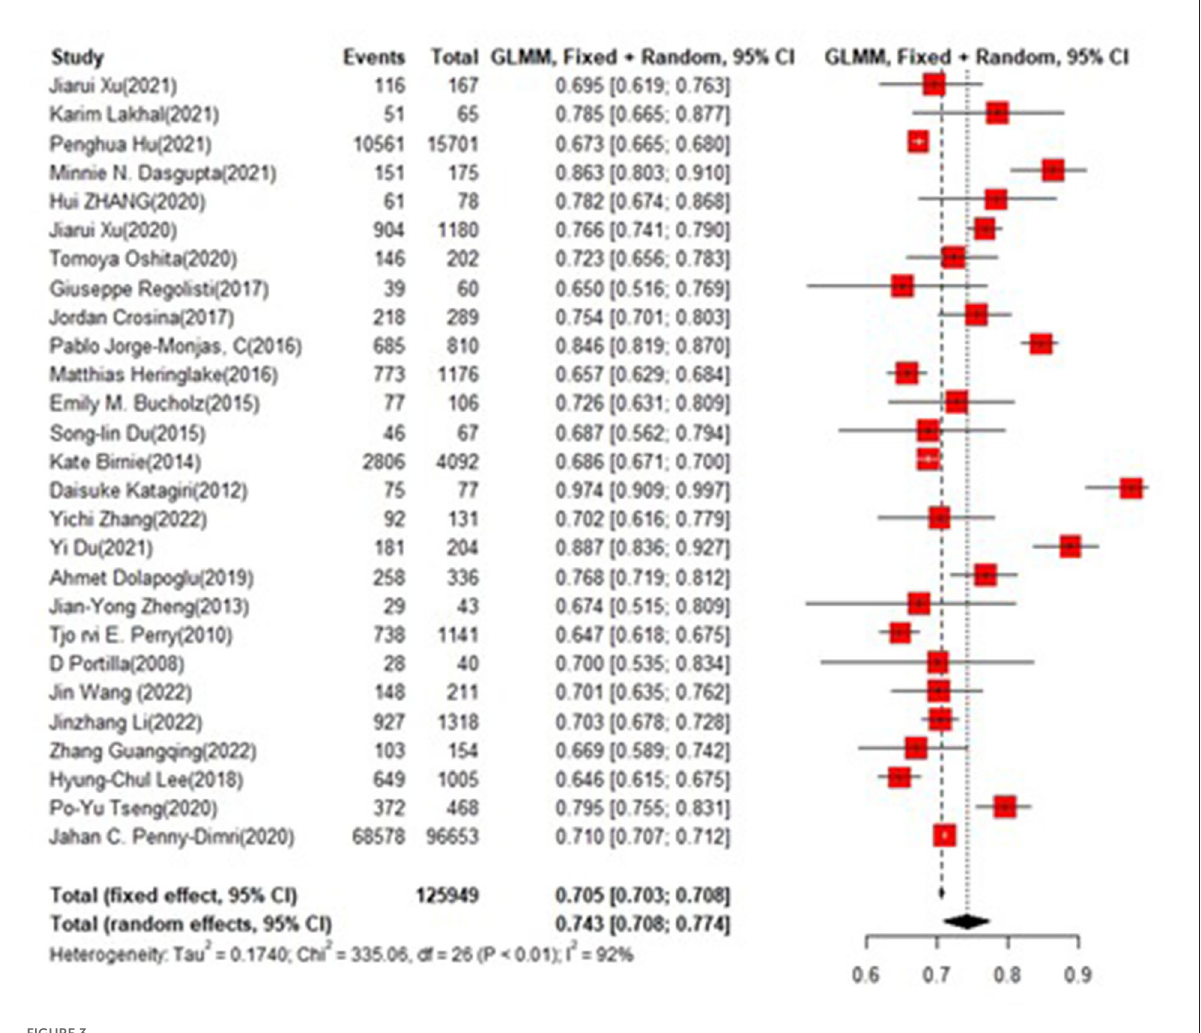
FIGURE3 Accuracy of the machine learning-based model in the training set: logistic